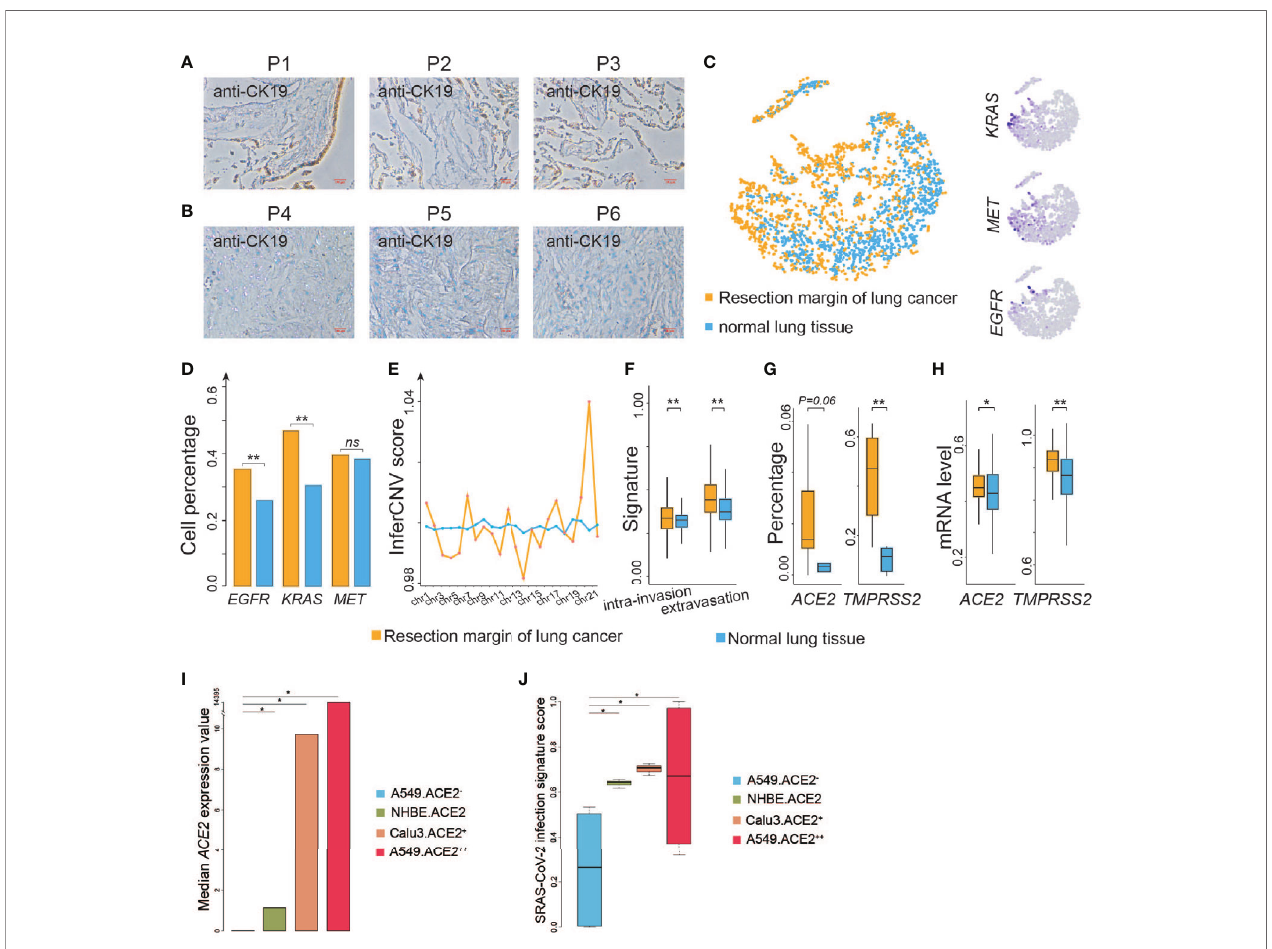
FIGURE 1 | ACE2 and TMPRSS2 are highly expressed at resection margins of lung cancer patients. (A) Immunohistochemistry images of resection margin tissues from lung cancer patients using anti-CK19 antibody. (B) Immunohistochemistry images of non-cancer samples using anti-CK19 antibody. (C) Left: t-SNE plot of epithelial cells from the resection margins of lung cancers and normal lung tissues. Right: Distribution of the indicated cell marker genes overlaid on a 2D-tSNE plot. (D) Comparison of the percentage of indicated genes expressed in epithelial cells between the resection margin of lung cancers and normal lung tissues. (E) Comparison of inferCNV scores of cells between the resection margin of lung cancers and normal tissues across indicated chromosomes. (F) Comparison of intra-invasion and extravasation signature scores between indicated groups. (G) Comparison of the percentage of ACE2 and TMPRSS2 expressed in cells between indicated groups. (H) Comparison of mRNA levels of ACE2 and TMPRSS2 between indicated groups. (I) Bar plot shows median value of ACE2 expression in different cell lines. A549.ACE2-, none ACE2 expressed SARS-Cov-2 infected A549 cell lines; NHBE.ACE2, low ACE2 expressed SARS-CoV-2 infected primary human lung epithelium cell lines; Calu3.ACE2+, median ACE2 expressed SARS-Cov-2 infected Calu3 cell lines; A549.ACE2++, high ACE2 expressed SARS-Cov-2 infected A549 cell lines. (J) Boxplot shows SARS-Cov-2 infection signature score in different cell lines as shown in (I) . *P < 0.05 (Wilcoxon rank sum test), **P < 0.01 (Wilcoxon rank sum test), NS, not signi fi